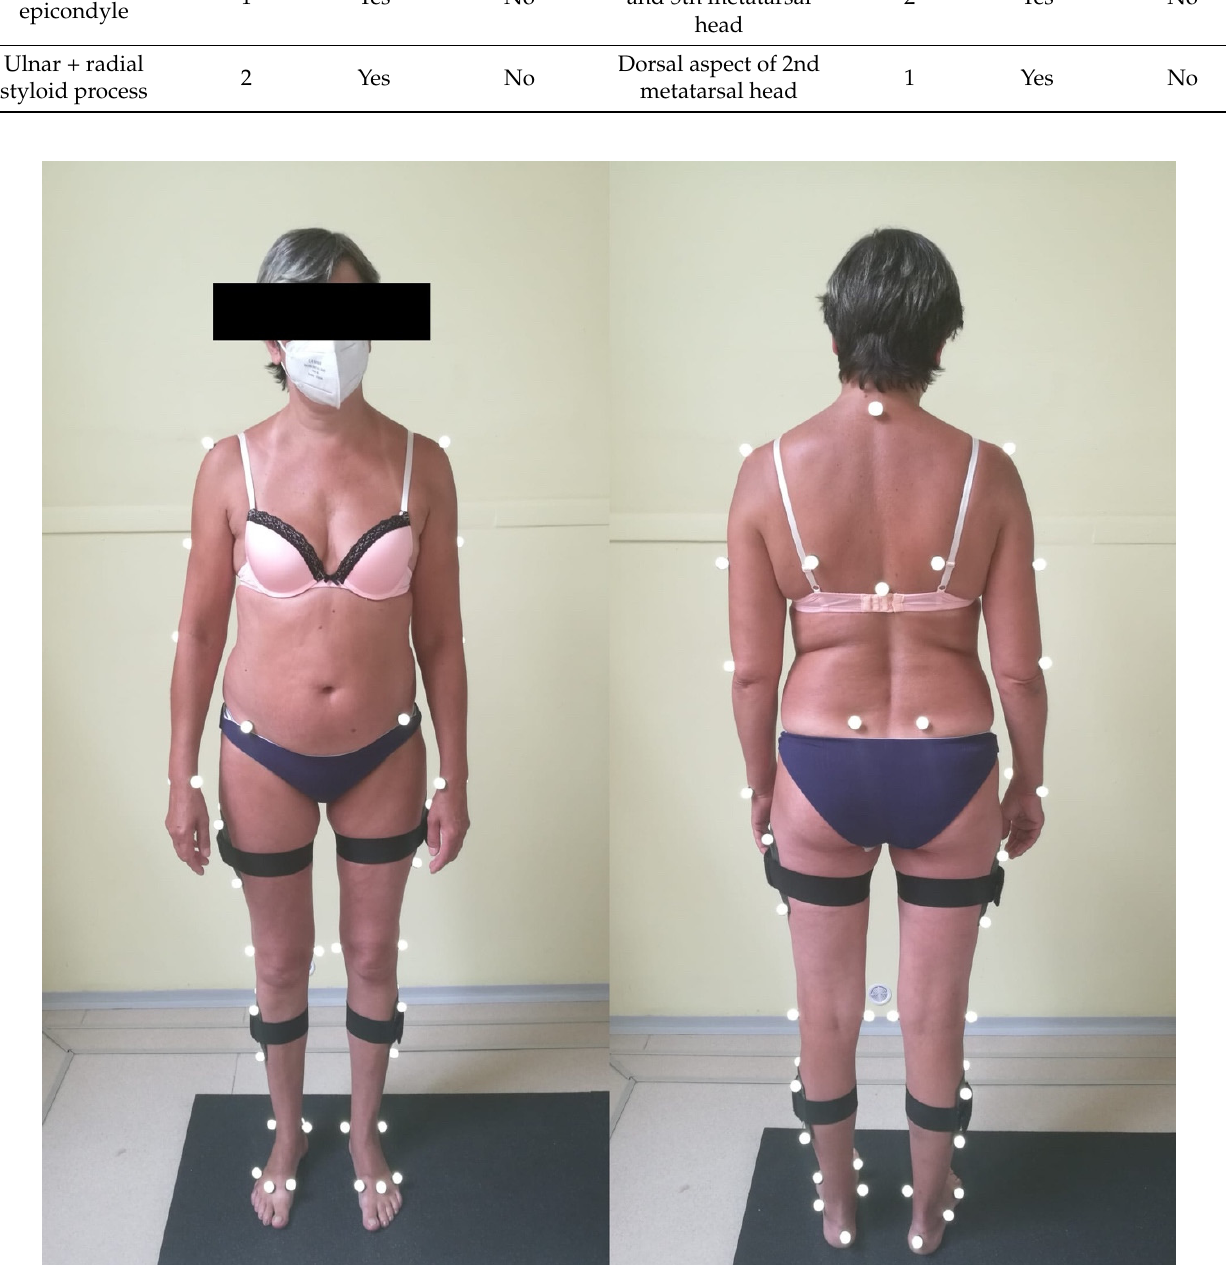
Figure 2. A patient marked with 50 passive reflective markers, placed individually or in clusters of four above major anatomical structures via adhesive tape. Placement was based on identifying anatomical landmarks via the atlas of Sint et al. [7]. A total of 50 markers were used for static system calibration and 42 for dynamic anal- ysis. After initial calibration in the standing position, the patient was asked to walk at a natural pace across the length of the laboratory. Kinematic data was then recorded via the